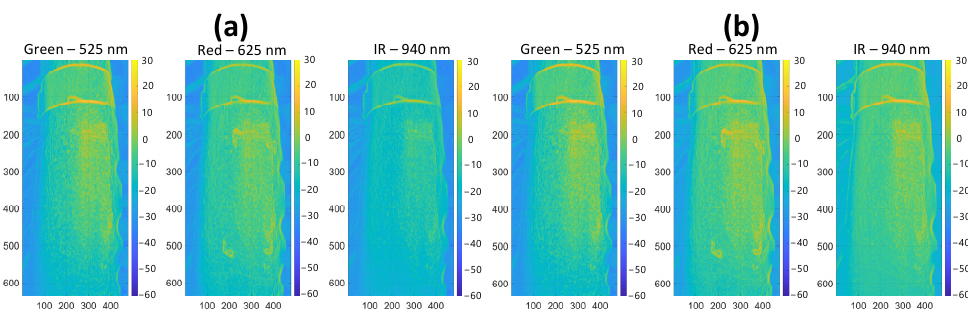
Figure 21. Amplitude AC maps, 3- λ mode: ( a ) before calibration; ( b ) after